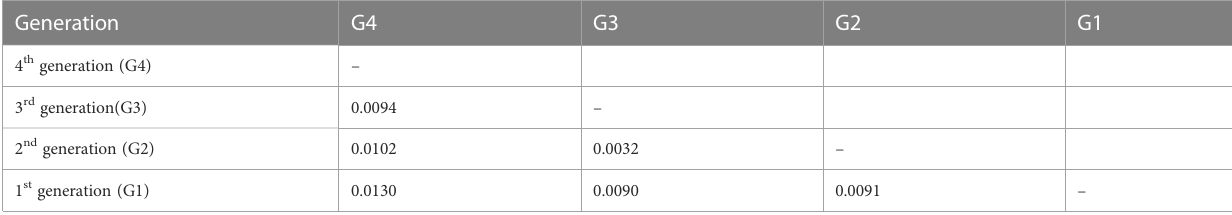
TABLE 3 Genetic differentiation among the Chinese fi r different breeding population generations.